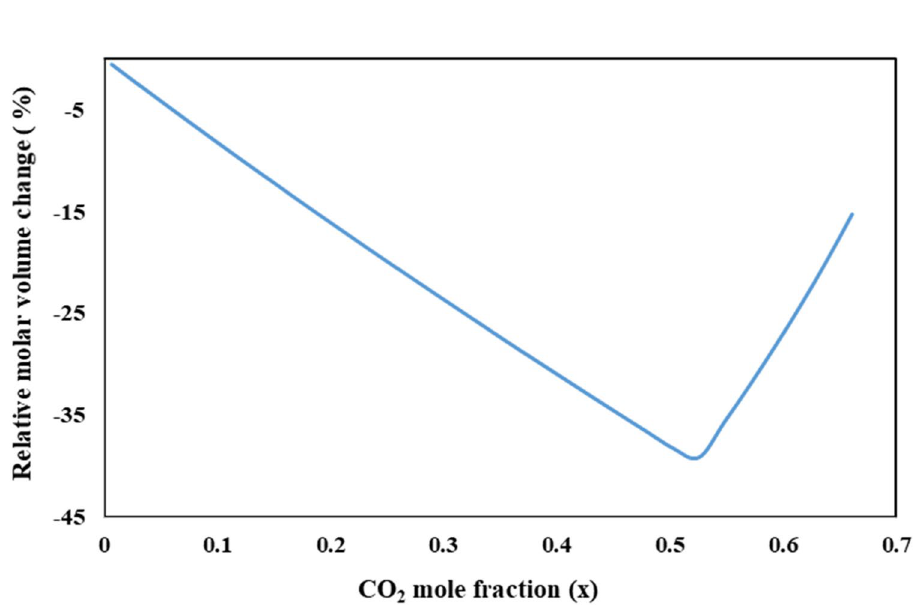
Figure 3. Relative molar volume change of the liquid phase vs. CO 2 mole fraction in liquid phase, for the binary system (DMSO–CO 2 ) at 328